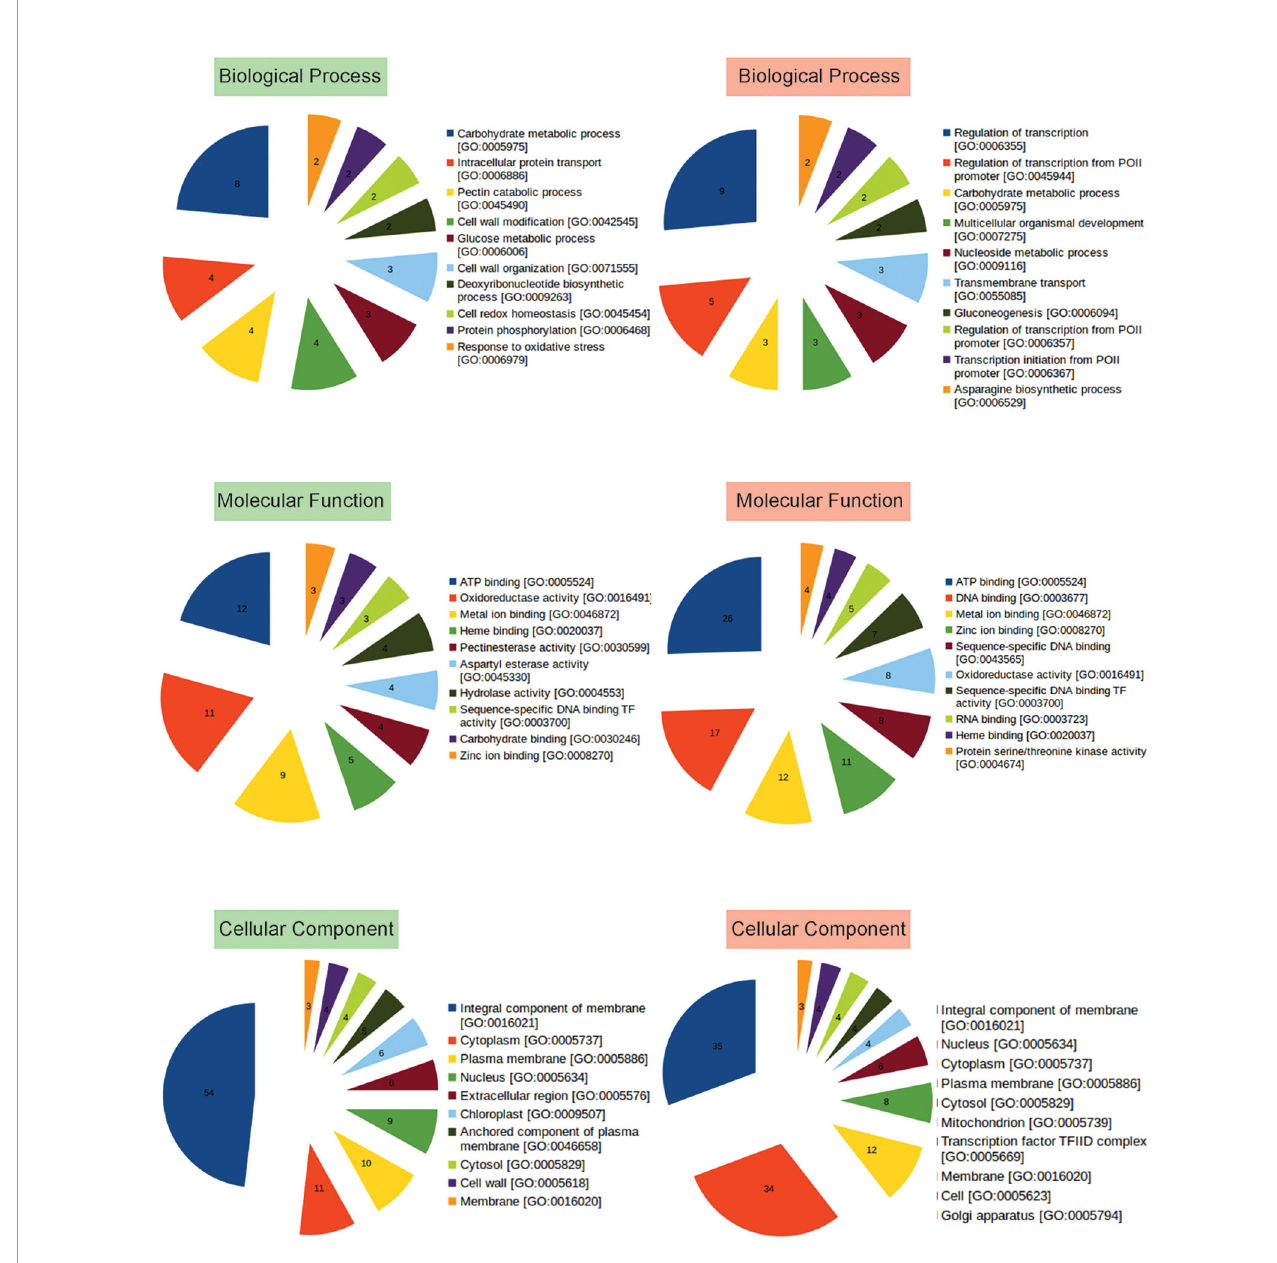
FIGURE 3 | Representation of functional classi fi cation of up and downregulated genes into Biological Process, Molecular Function, and Cellular Component categories by GO analysis. Number in each pie represents how many times the function (BP, CC, MF) is expressed (abundance) in the data. GO based categorization of upregulated genes are labeled in green, while those of downregulated genes are labeled in